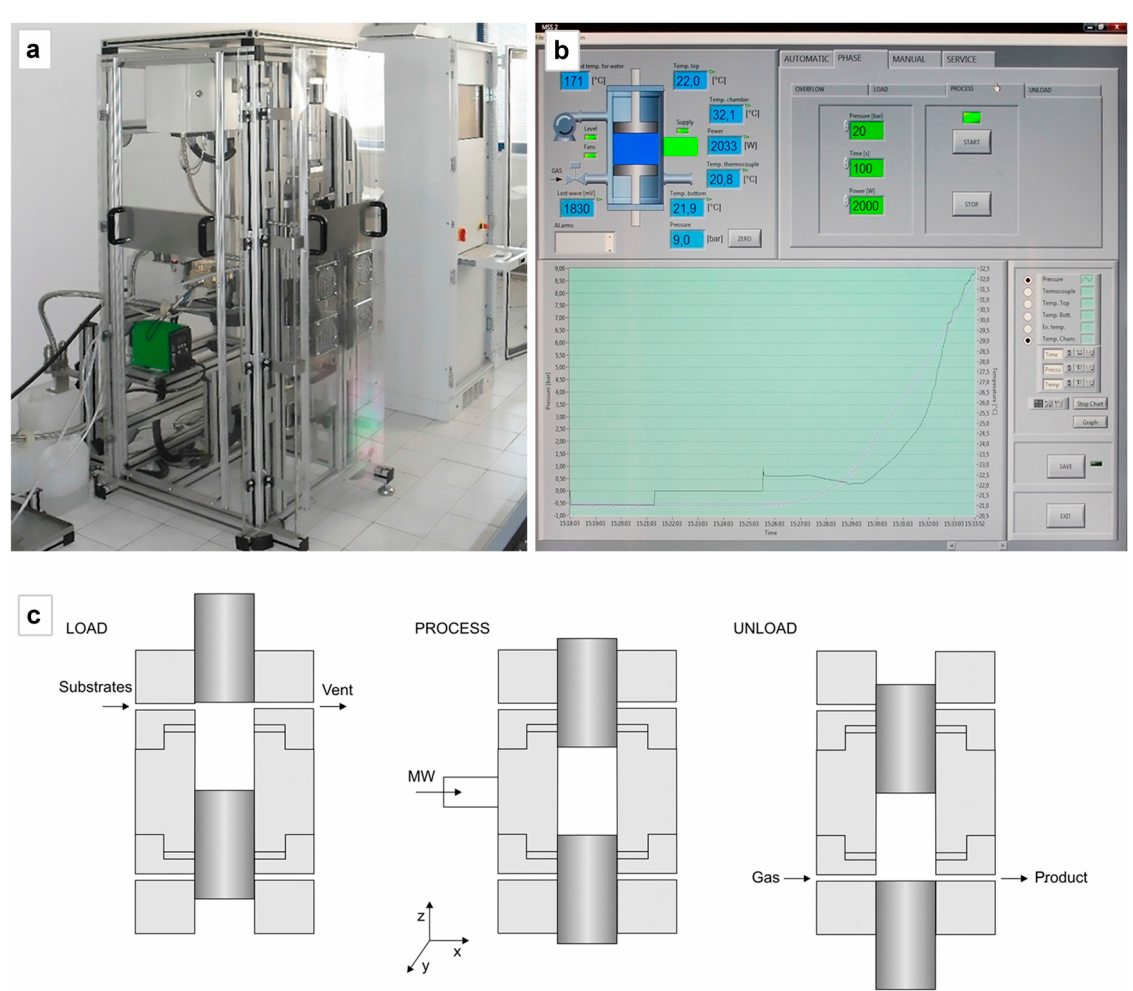
Figure 7. The MSS-2 batch reactor. ( a ) MSS2 reactor general view; ( b ) Control panel and a process diagram; ( c ) Schematic presentation of the reactor operation: loading, processing,